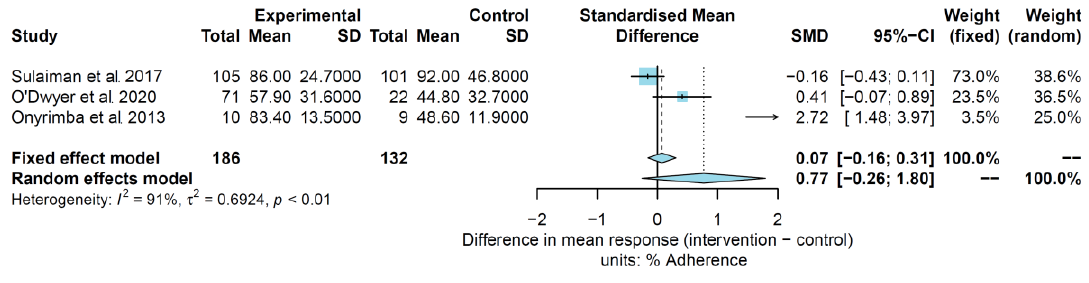
Figure 5. Adherence outcomes up to 3 months. References: [53,58,61].